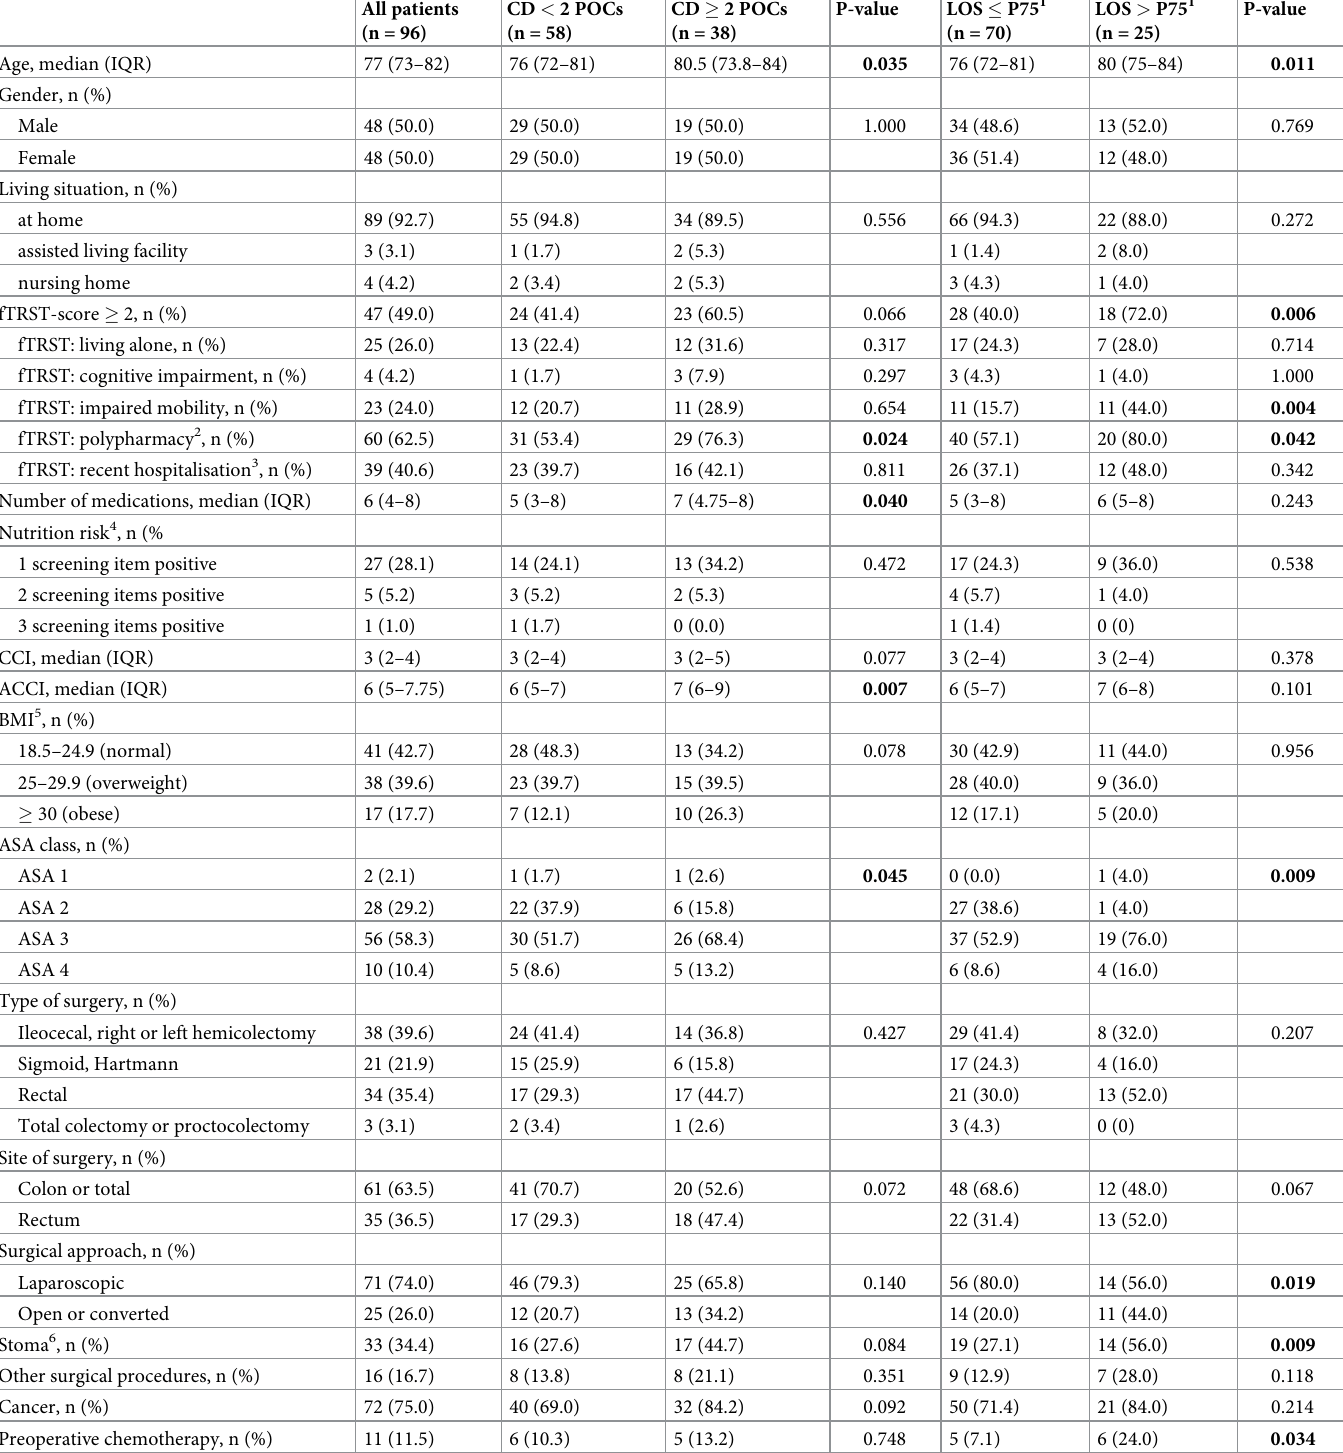
Table 1. Baseline characteristics of the total study sample and in relation to the primary outcomes (univariable